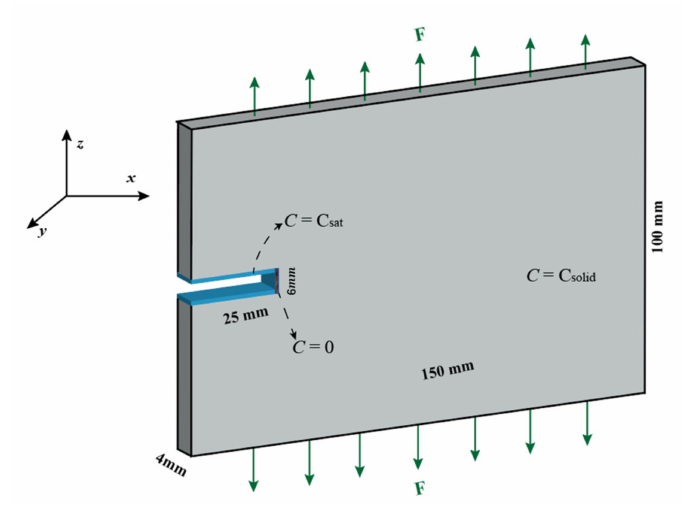
Figure 6. Geometry and boundary